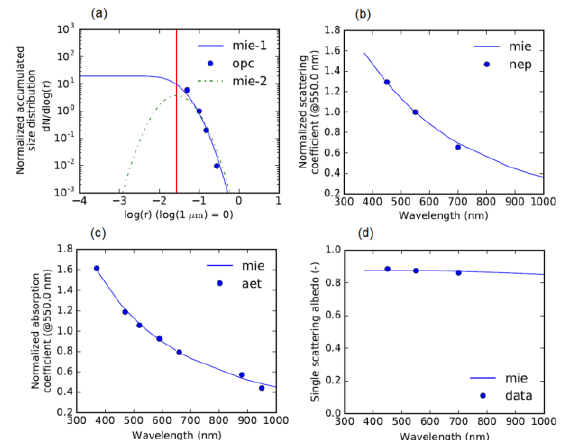
Fig. 2 Fitting of observed aerosol parameters with Mie scattering calculation for the case of data observed at 10:00 JST on March 20, 2017.